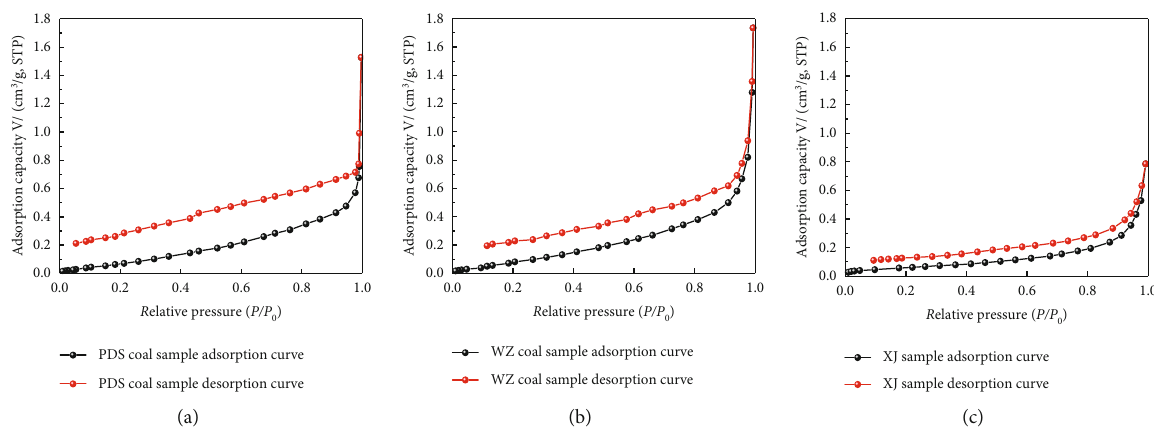
Figure 3: Experimental coal sample adsorption-desorption curve.